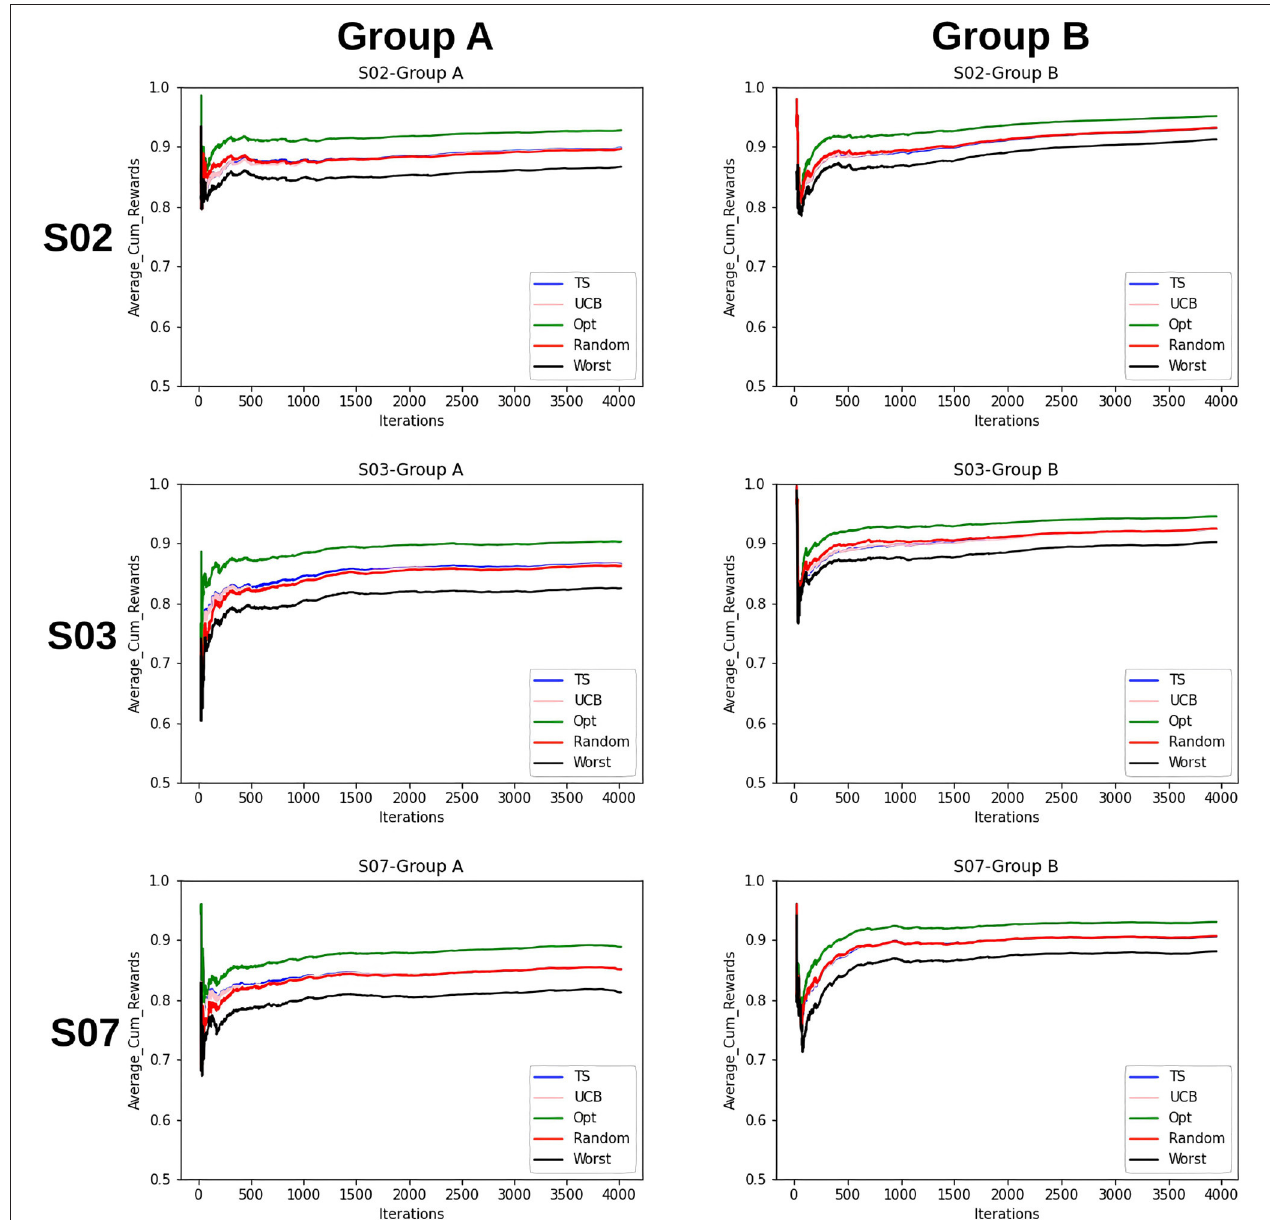
FIGURE 5 | Average cumulative reward per iteration/time-step for the items for Group A and B. Here, the first column represents selections by Group A and the second column by Group B. Five samplers as discussed above have been compared here.